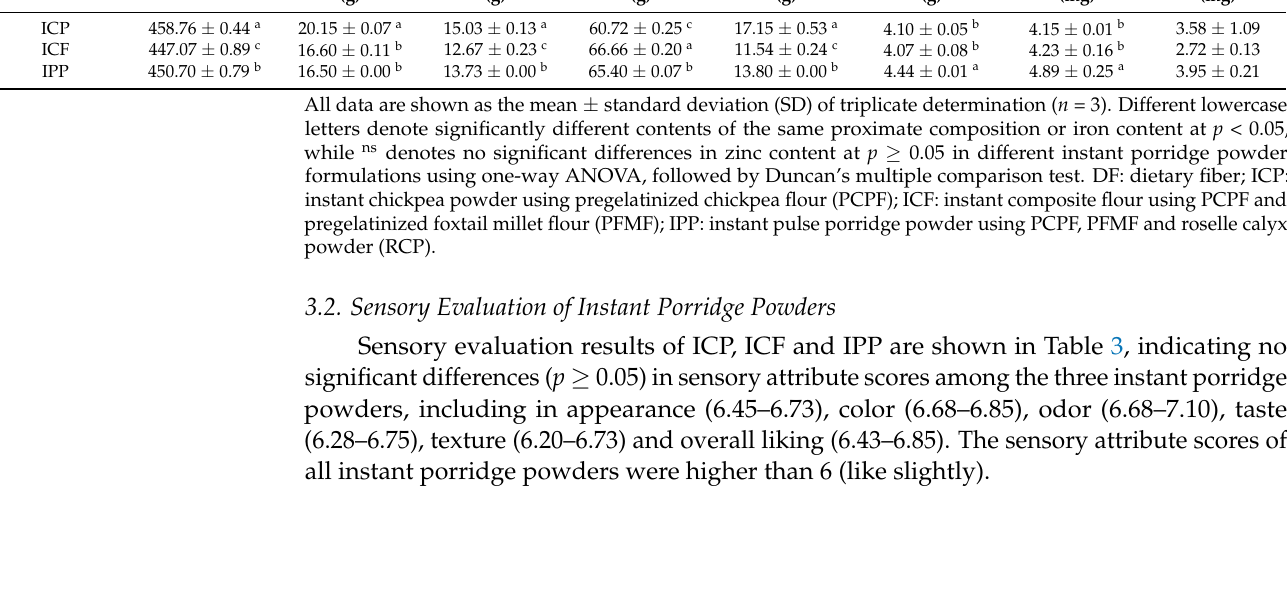
Table 2. Proximate, iron and zinc contents of instant porridge powders (per 100 g dry weight).